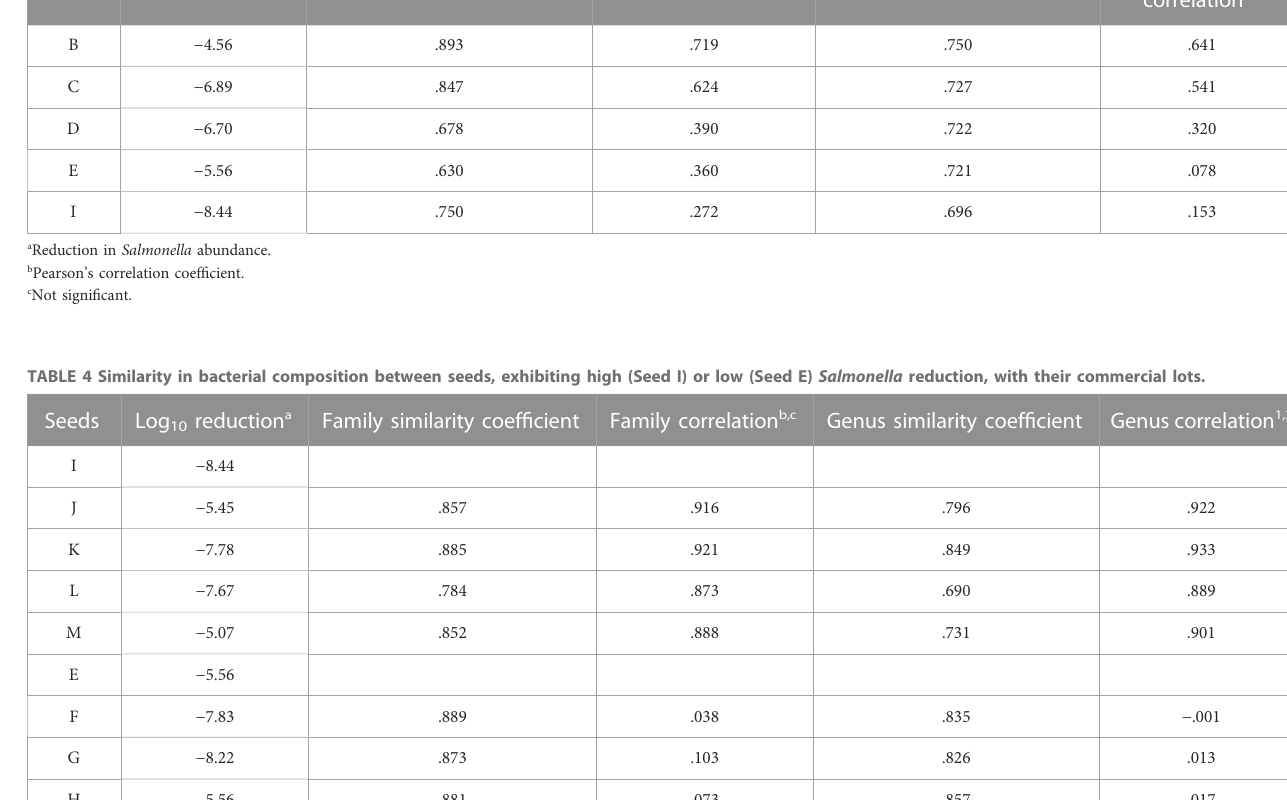
TABLE 3 Similarity in bacterial composition of the master seed A with seeds B, C, D, E, or I. Seeds